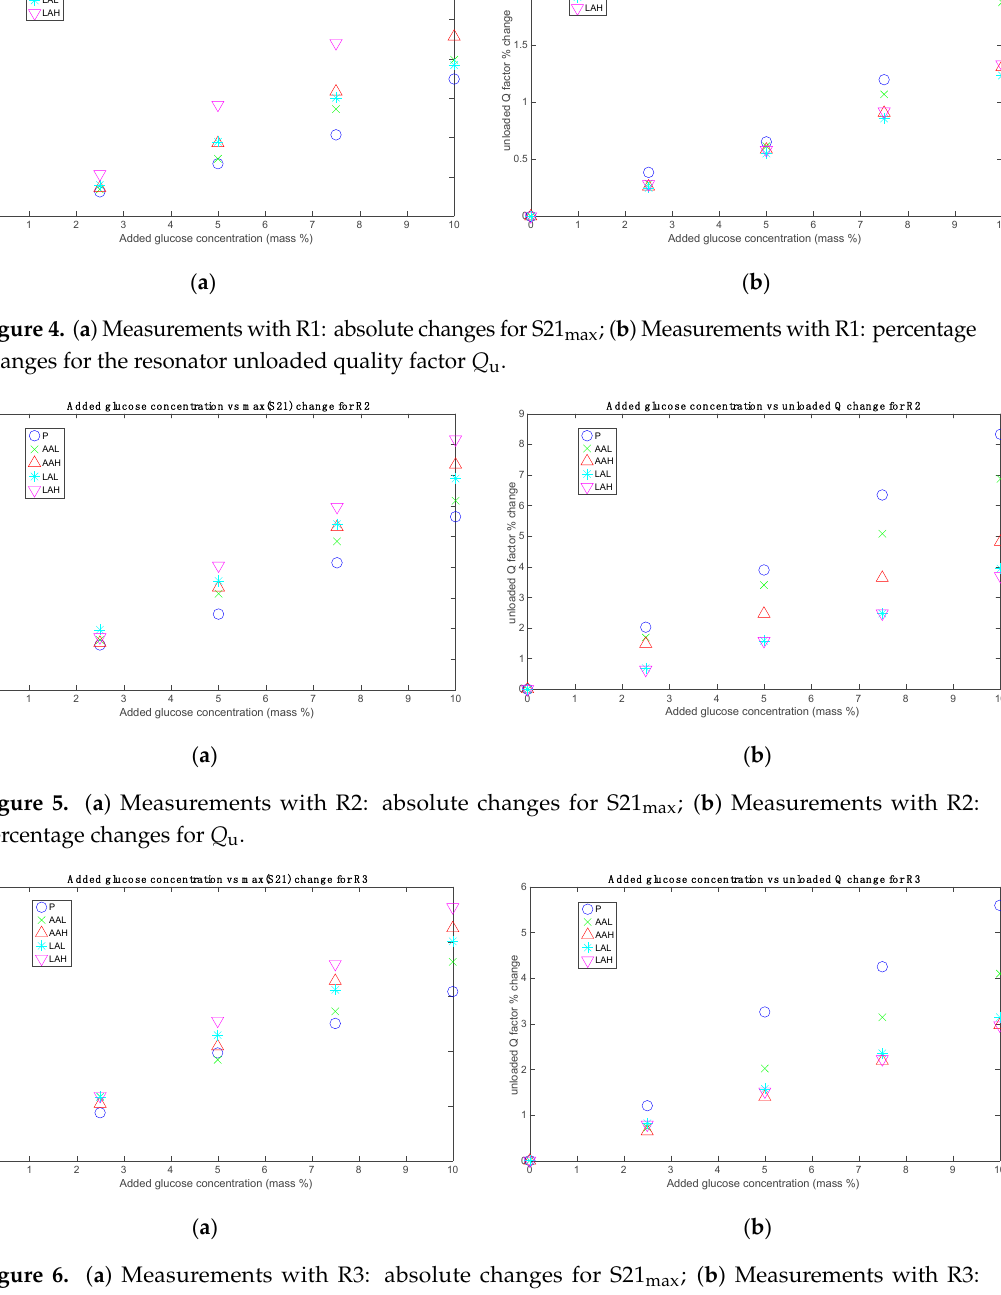
Figure 6. ( a ) Measurements with R3: absolute changes for S21 max ; ( b ) Measurements with R3: